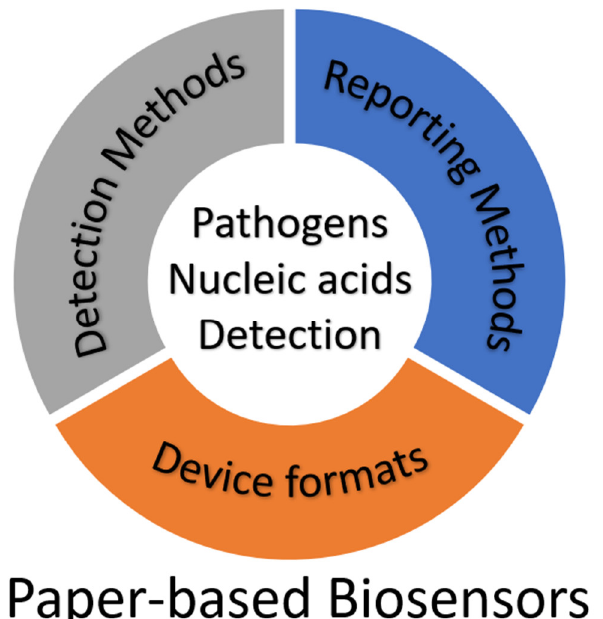
Figure 1. Schematic of the three essential components of paper-based biosensors for detecting nucleic acids from pathogens.